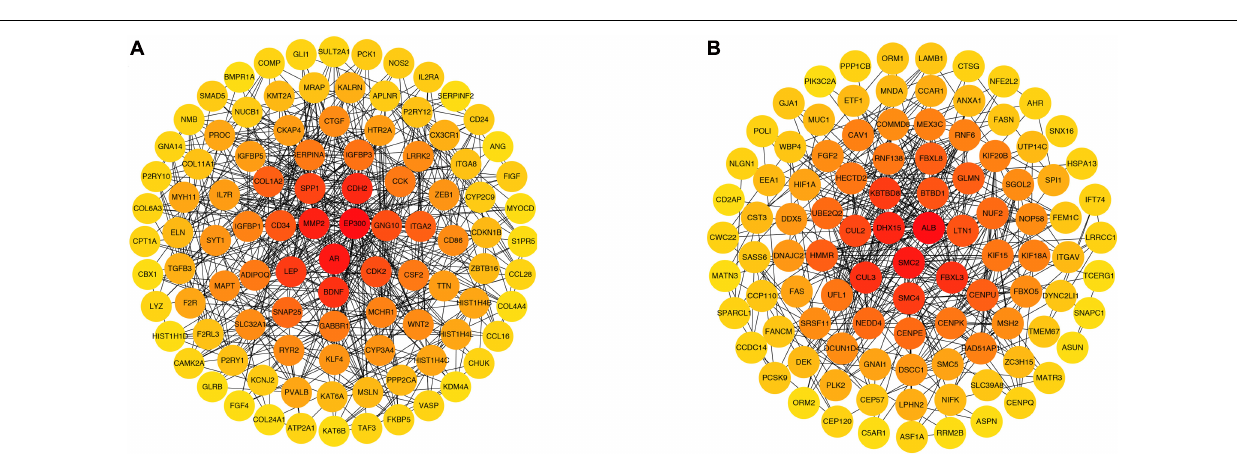
FIGURE 6 | Protein–protein interaction networks of genes in (A) green and (B) brown modules. Each node represents a gene, and each node is connected by a degree. The color changes from red to yellow as one moves from the inside toward the outside, and the degree decreases from red to yellow. The genes with top 100 degrees and genes with the same degrees as the 100th gene were also